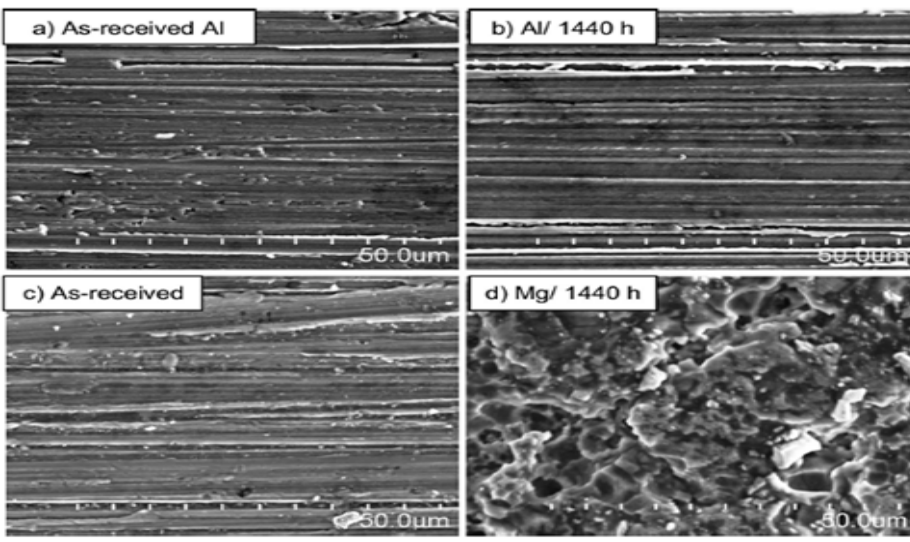
Figure 12. Scanning Electron Microscope (SEM) image of Mg and Al before and after immersion [68].